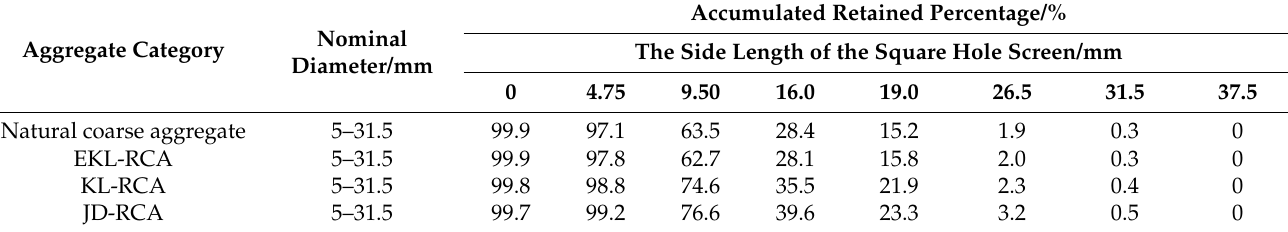
Table 6. Comparison of aggregate particle